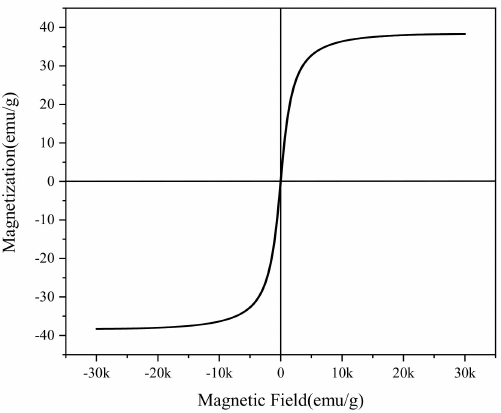
Figure 6. CoFe 2 O 4 @CNTs magnetic hysteresis loop obtained at 300